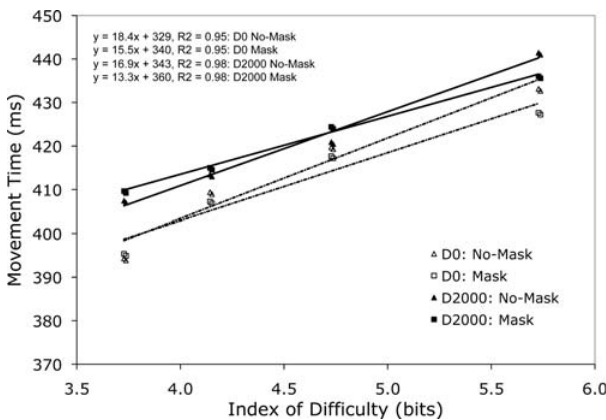
Figure 2. Movement time (ms) for D0 and D2000 group no- mask and mask trials as a function of target index of difficulty. In addition, the top left hand corner of the figure presents regression equations and R 2 for each experimental condition.